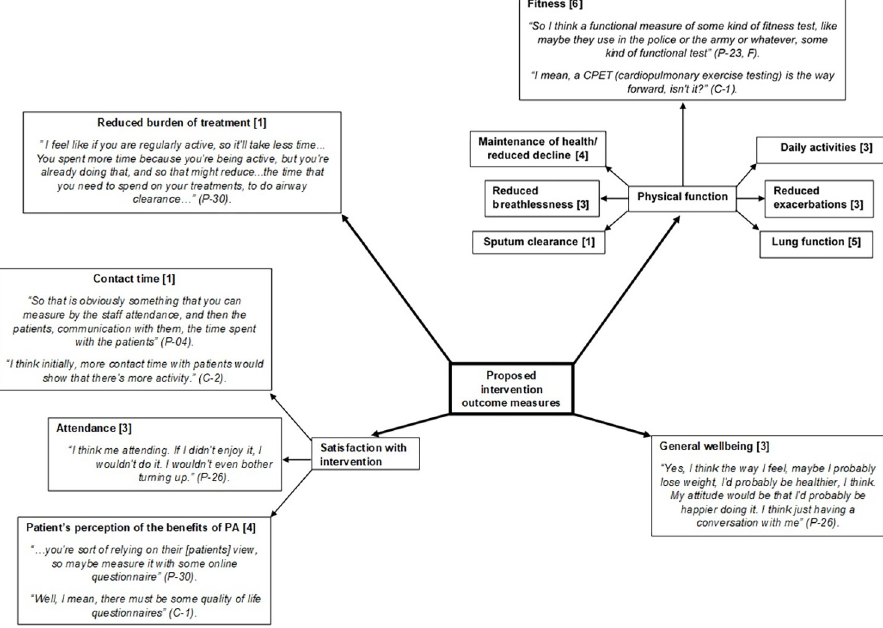
Fig 7. Pen profile displaying participant (patients (n = 9) & clinicians (n = 3) selected intervention outcome measures with illustrative quotes, associated participant number and frequency count provided in square